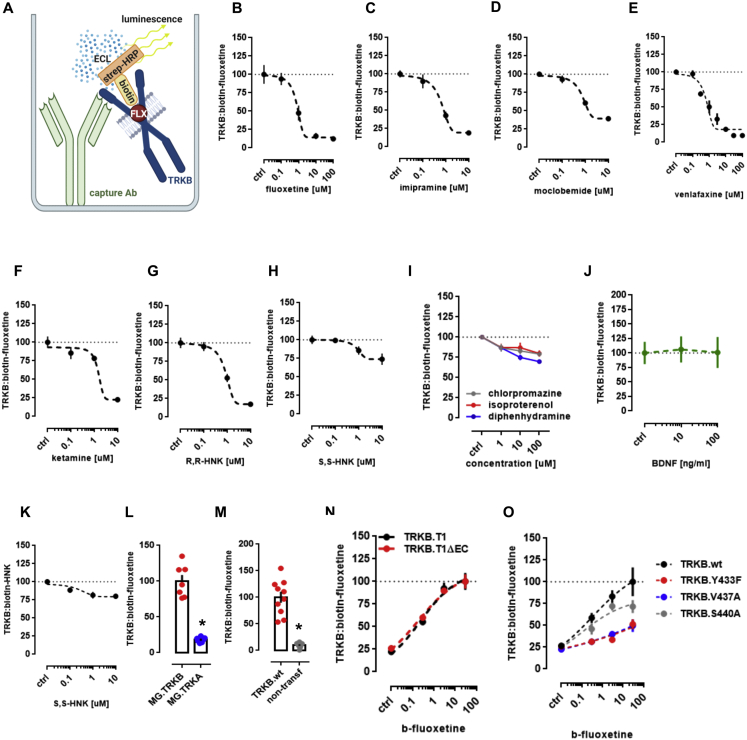
Antidepressants bind to TRKB transmembrane domain, related to Figure 2Lysate from HEK293T cells expressing TRKB were submitted to ligand binding assays. (A) Schematic representation of the biotinylated fluoxetine interaction with immobilized TRKB. (B-J) Biotinylated fluoxetine (1 μM) interaction with TRKB is reduced by non-biotinylated (B) fluoxetine (n = 6/group), (C) imipramine (n = 8/group), (D) moclobemide (n = 10/group), (E) venlafaxine (n = 6/group), (F) ketamine (n = 8/group), (G) R,R-HNK (n = 8/group), but not reduced by (H) S,S-HNK (n = 8/group), (I) chlorpromazine (n = 8/group), isoproterenol (n = 8/group) or diphenhydramine (n = 8/group), or (J) BDNF (n = 6/group). (K) Biotinylated R,R-HNK (1 μM) interaction with TRKB is not reduced by S,S-HNK (n = 12/group). (L,M) Biotinylated fluoxetine interaction with (L) TRKA (n = 7/group) from MG87 cells, or (M) lysates from non-transfected HEK cells (n = 10/group) are negligible compared to TRKB. The interaction of biotinylated fluoxetine is not altered in (N) TRKB lacking most of the intra and extracellular domains (TRKB.T1ΔEC, n = 12/group), but it is reduced by (O) V437A and Y433F mutations, and partially attenuated by S440A (n = 6/group).